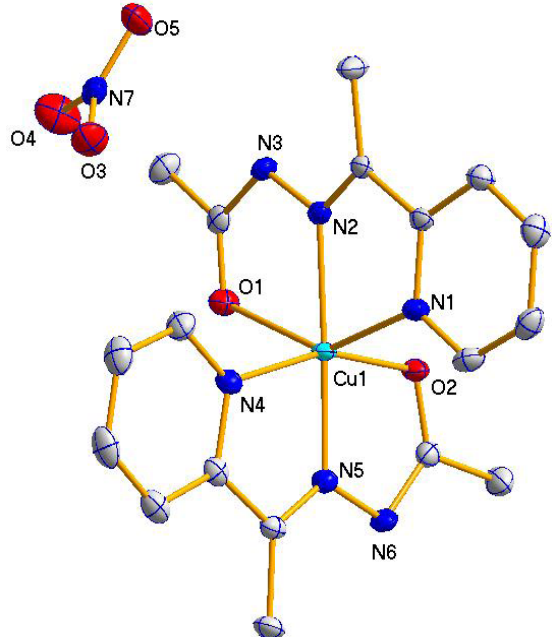
Figure 1. An ORTEP plot of complex 1 . Ellipsoids are drawn from 30% probability label. Hydrogen atoms are omitted for clarity.